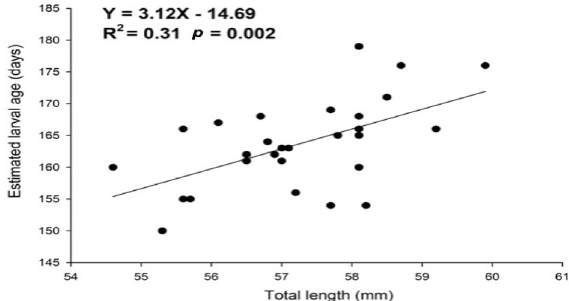
Figure 3. The regression between total length and estimated age of Japanese glass eels transported to eastern Taiwan.